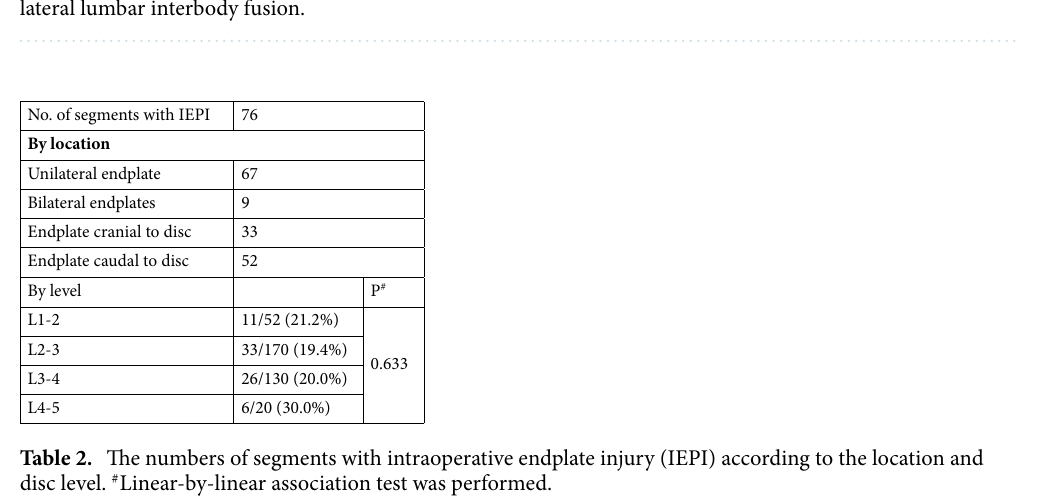
(Table 3). Sex distribution was significantly different between the two groups (Table 3). When 372 LLIF segments